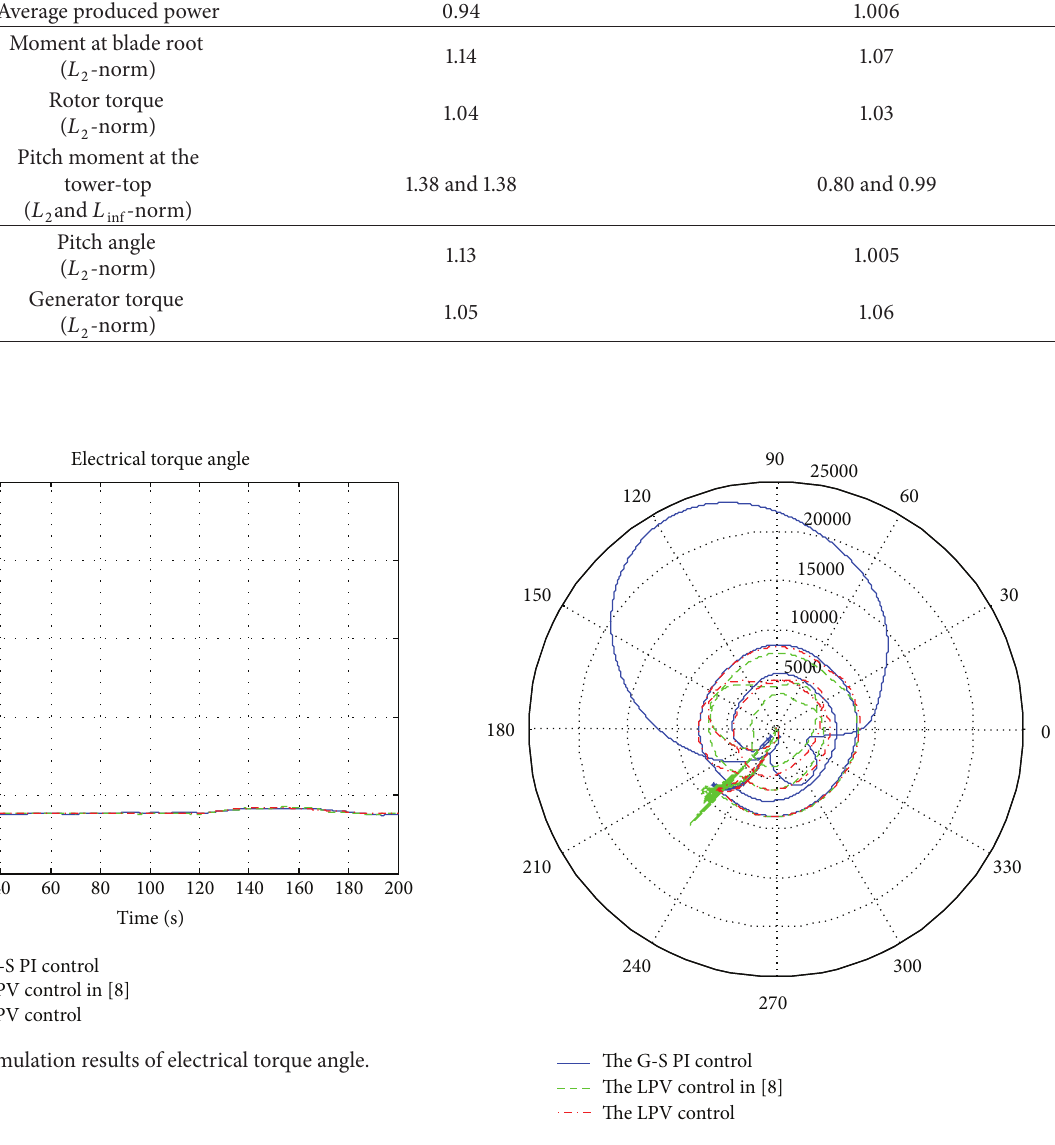
Figure 17: Electrical torque versus torque